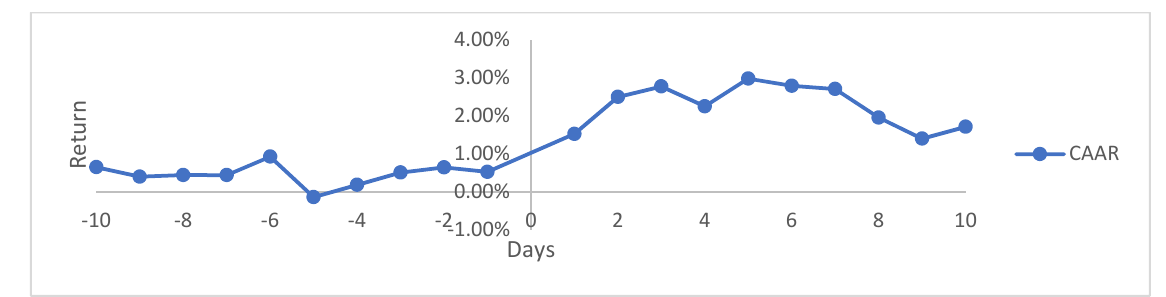
Figure 3. Cross-border acquisitions. Source: Authors’ own calculation.